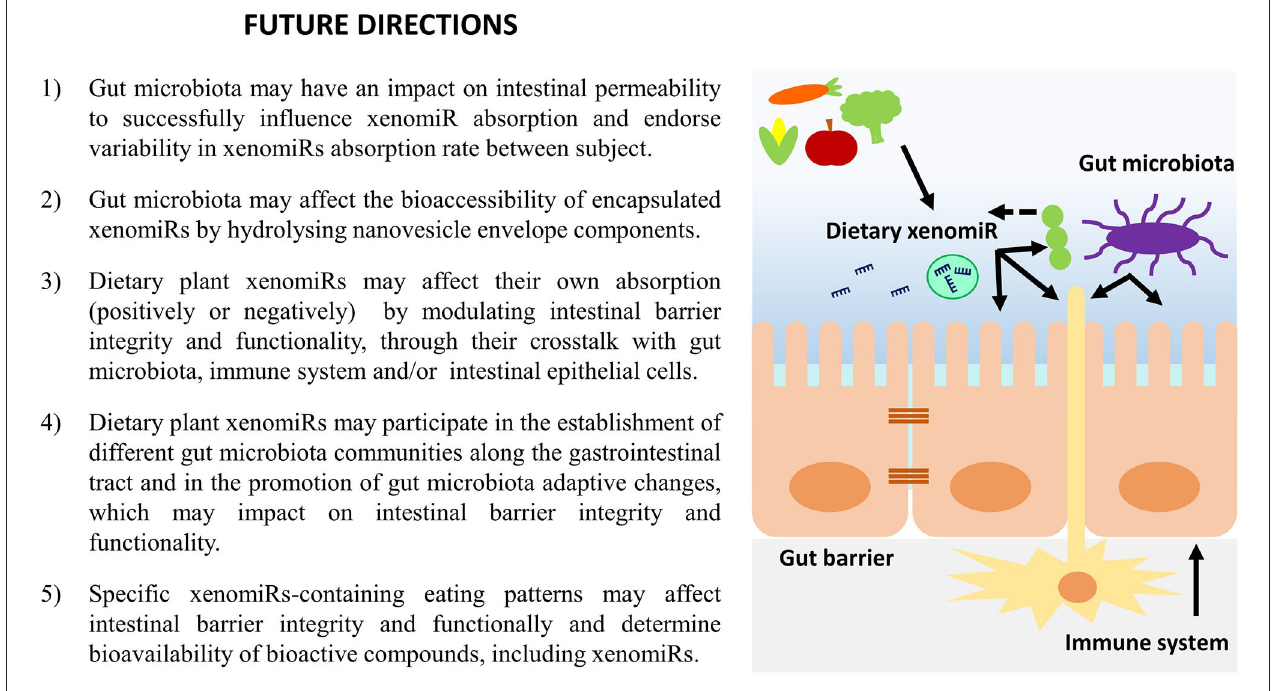
FIGURE 2 | Hypothesis for the effect of dietary xenomiRs on gut microbiota, intestinal immune system and gastrointestinal barrier integrity and